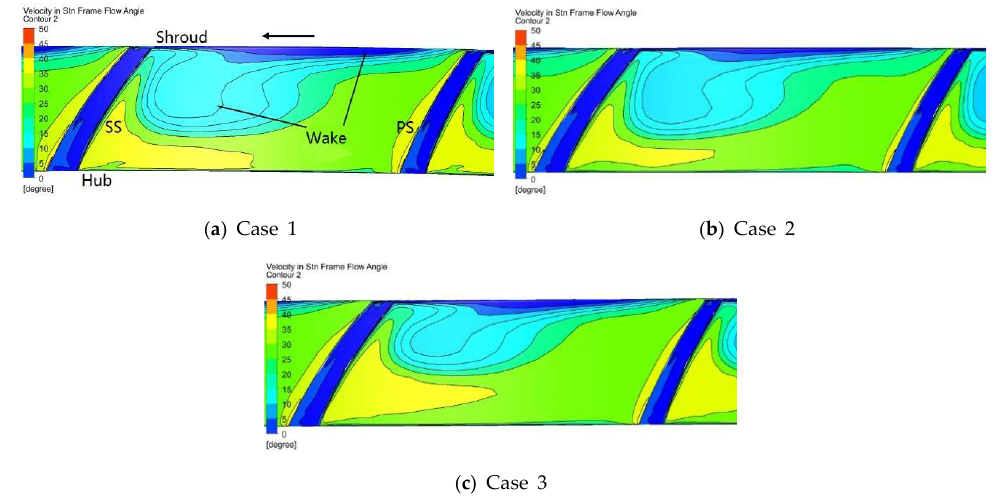
Figure 16. Comparison of the impeller outlet flow angles.